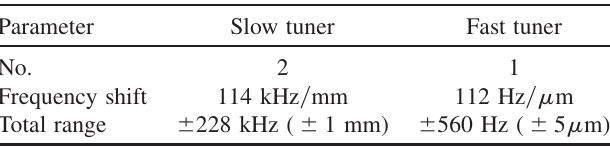
TABLE IV. Frequency shift and total range of the bellow tuners for the first cavity.